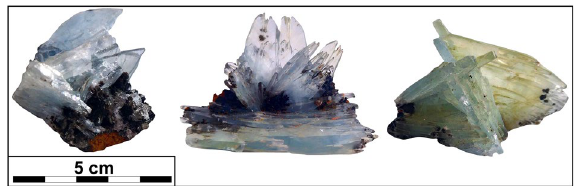
Figure 2. An example of gem-quality specimens of blue barite from Jebel